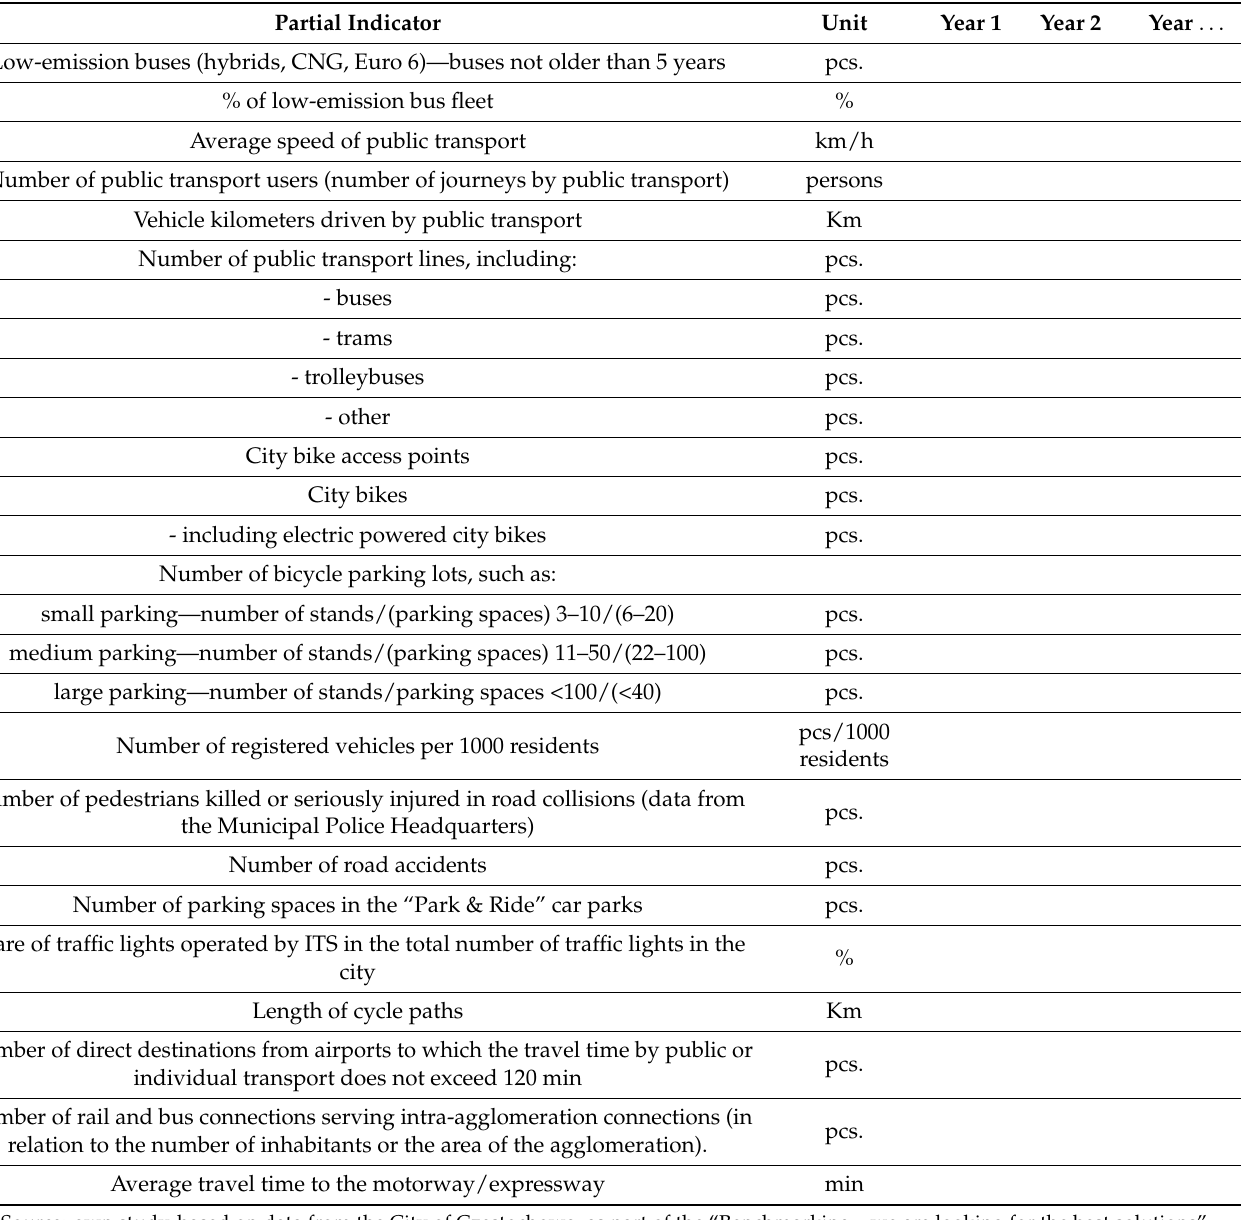
Table 2. Area 1 concerning local transport, national and international accessibility, ICT infrastructure, sustainable transport system. The measure—“local